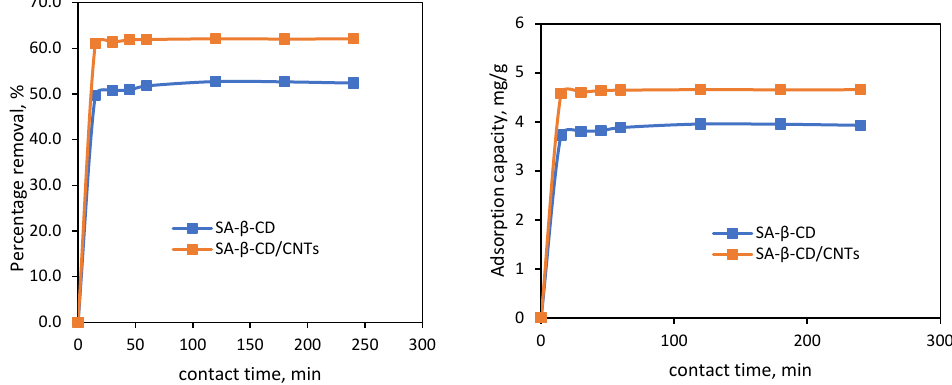
Figure 9. Effect of contact time on Ni(II) adsorption SA − β − CD hydrogel and SA − β − CD/CNTs hydrogel.